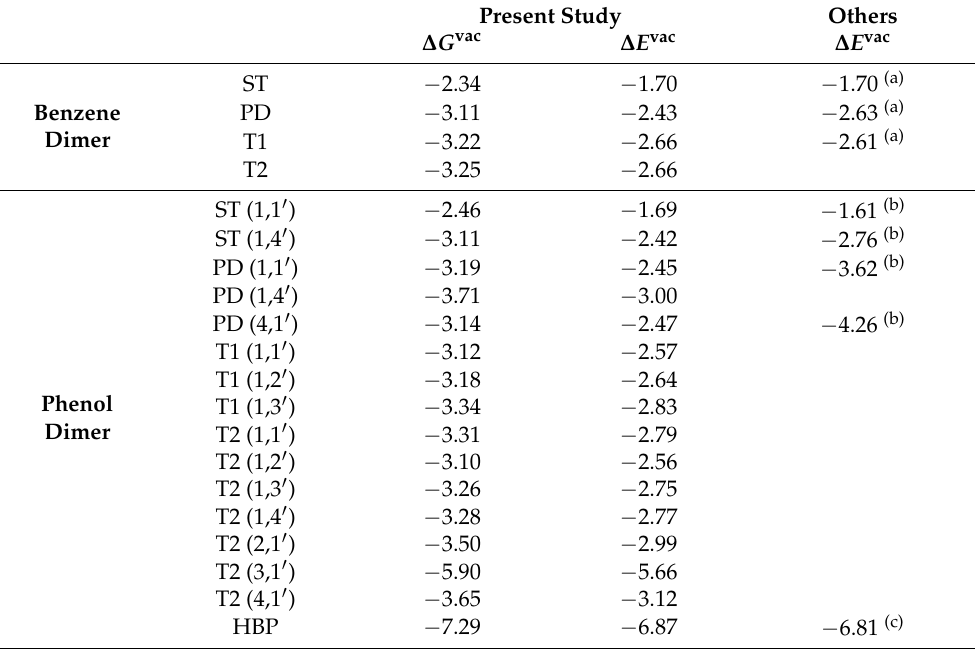
Table 1. Estimated binding energies ( ∆ E vac ) and binding free energies ( ∆ G vac ) of benzene and phenol dimer in vacuum. The listed values are in kcal/mol. ∆ E vac from other studies were cal- culated using (a) estimated CCSD(T)/aug-cc-pVQZ*, which is a modified aug-cc-pVQZ basis set lacking g functions on carbon and f functions on hydrogen [18]. (b) MP2/M062X/6-311++G(d, p ) [55]. (c) CCSD(T)/CBS [56].